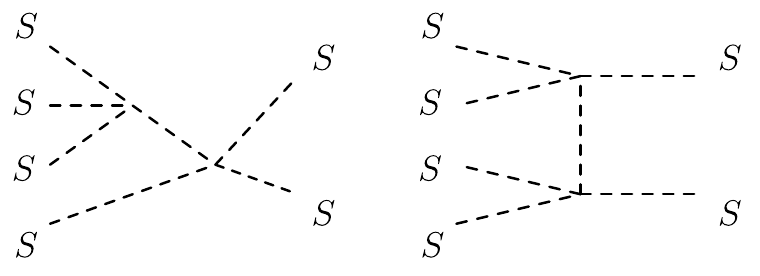
Figure 1 . Lowest order number changing